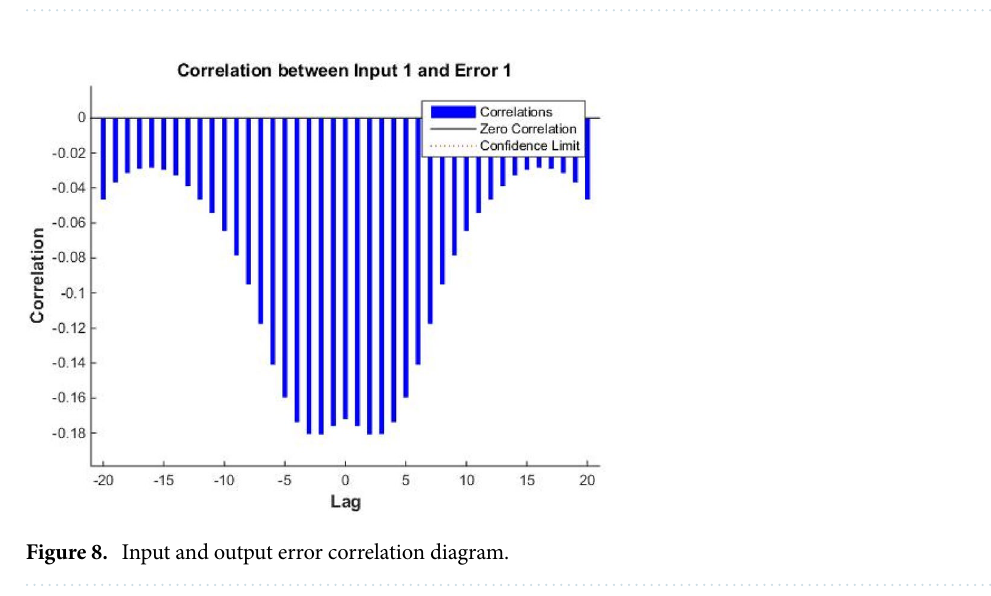
Figure 7. Error autocorrelation diagram.